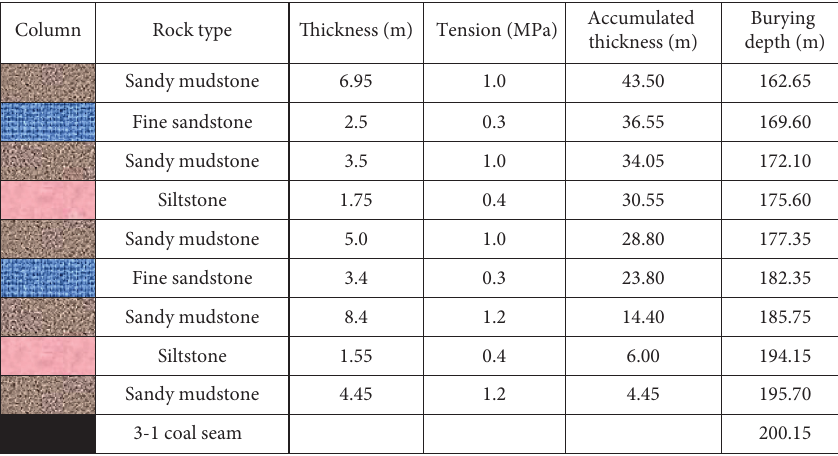
Figure 1: Borehole histogram in 103 working face.